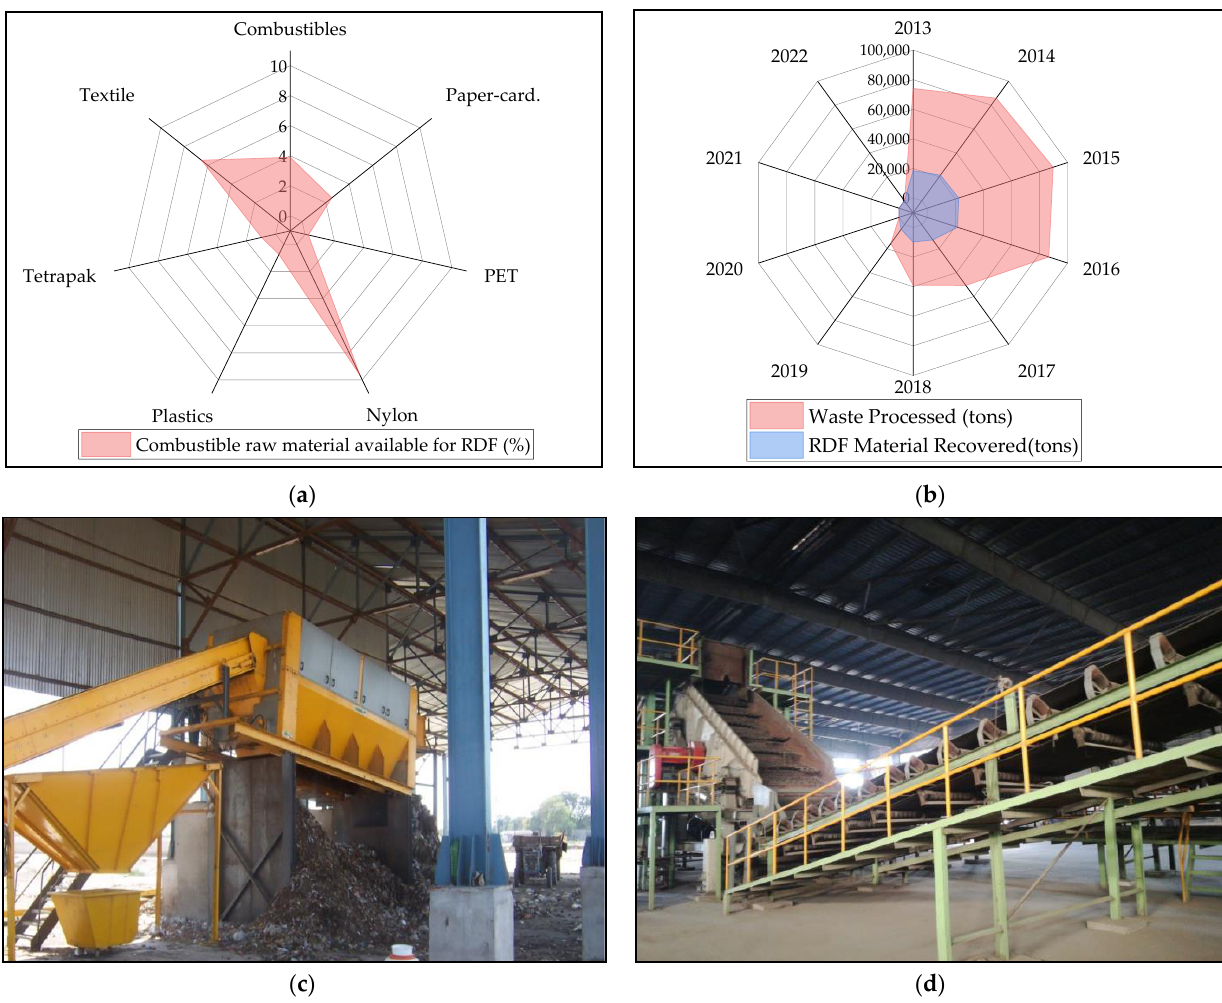
Figure 14. RDF plant processing and recovery details: ( a ) Percentage of combustible recoverable material for RDF; ( b ) Yearly detail of processed and combustible recovered material; ( c ) Compost plant at Lahore; ( d ) RDF plant at